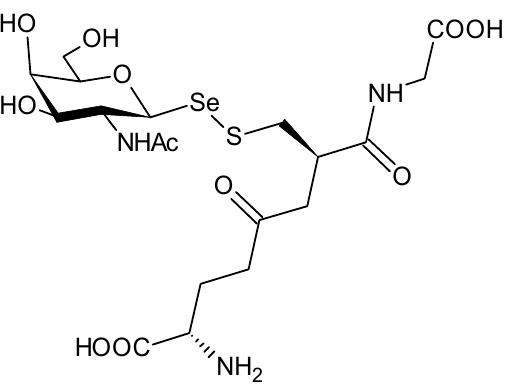
Figure 6. Hepatic metabolite A.